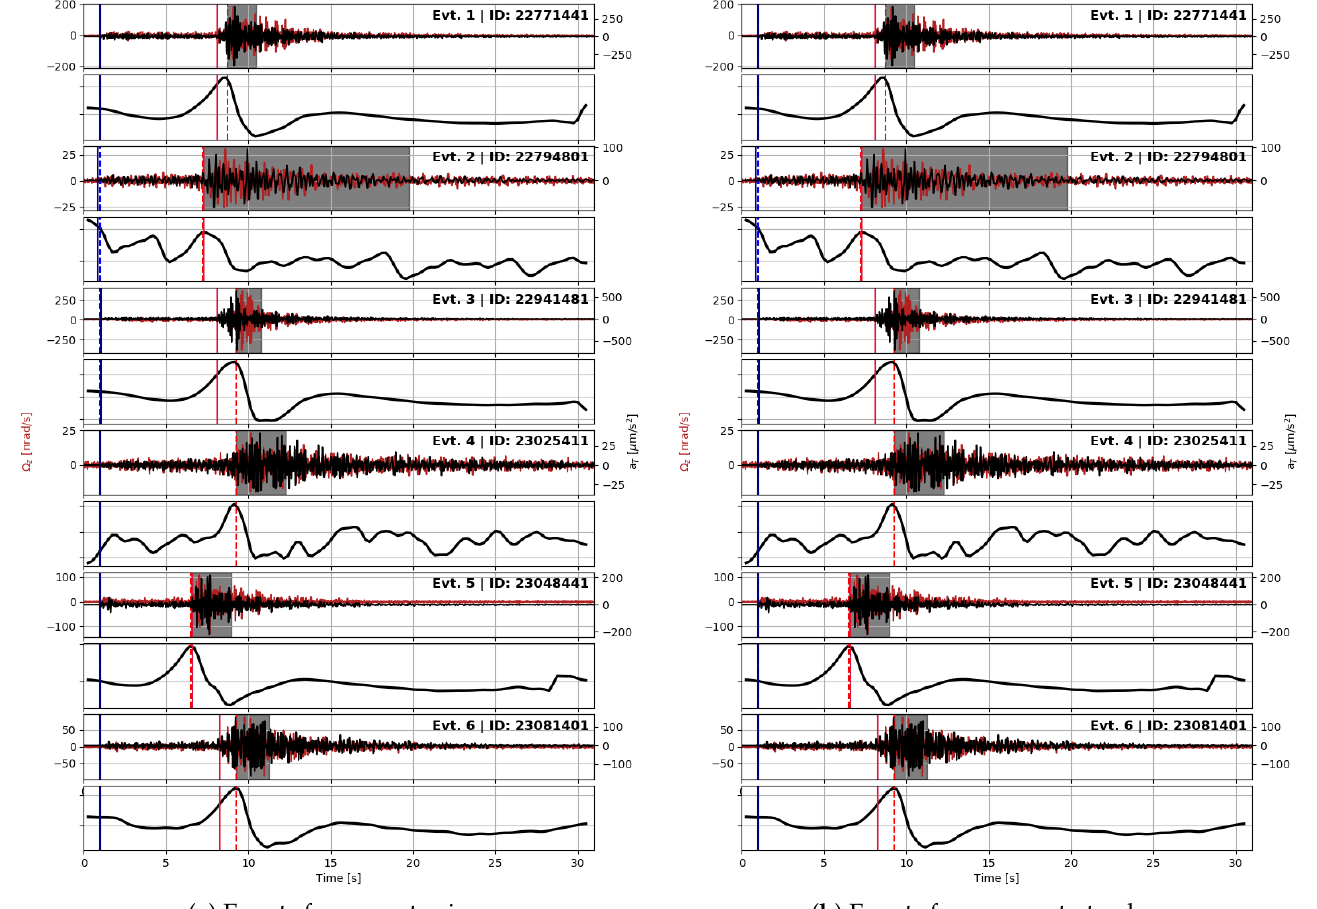
Figure 4. The analyzed events, from top: odd panels are a superposition of transverse acceleration (in black) and vertical rotation rate (in red), even panels the time derivative of the principal eigenvalue used for Sh waves phase picking. The latter is normalized with respect to its maximum value. Vertical lines indicate arrival times (P waves in blue, Sh waves in red) as picked by the routine used in this study (dashed lines) and published by the INGV (continuous lines). See explanation in the text for polarization